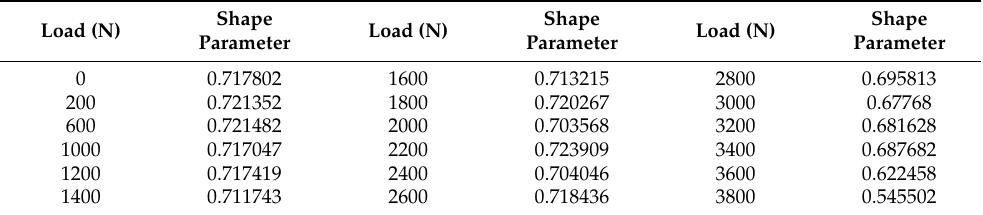
Table 6. The load and corresponding shape parameters of target grain (slenderness